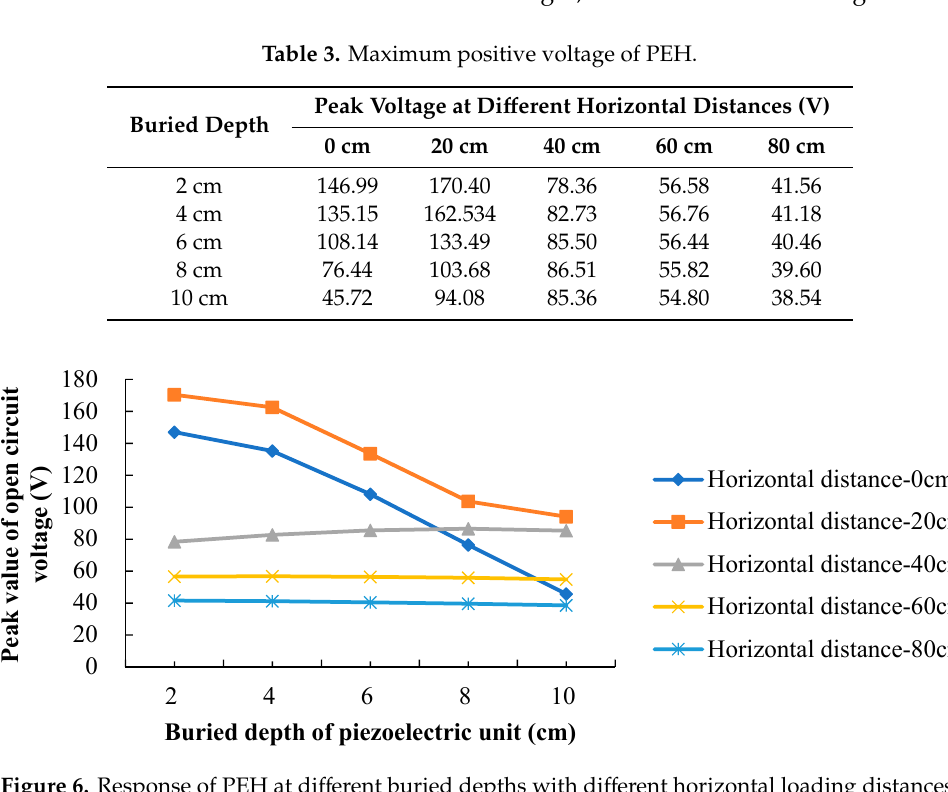
Table 3. Maximum positive voltage of PEH.